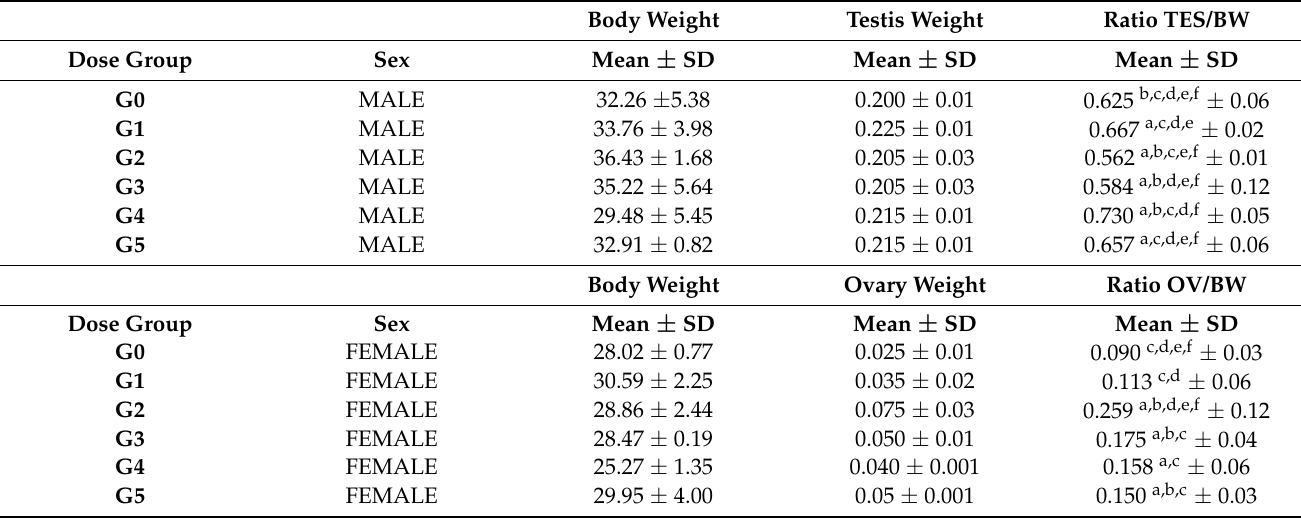
Table 3. Body weight, ovary and testis weight and relative reproductive organs weight/body weight of male and female mice per study group.